Question: What visual encoding does this figure use to show its data?
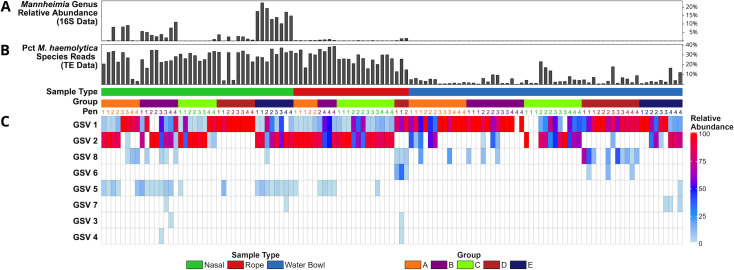
Answer: heatmap